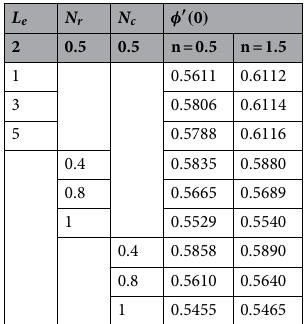
Table 5. Numerical analysis of Sherwood number φ ′ ( 0 ) for the values of L e .